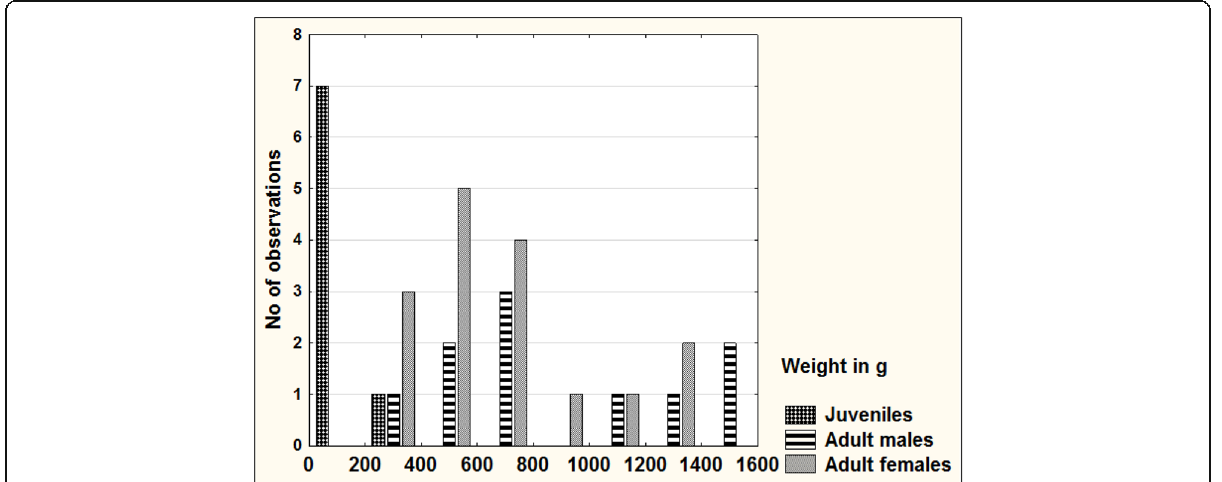
Fig. 5 Distribution of weight among 34 blunt-nosed vipers from Cyprus